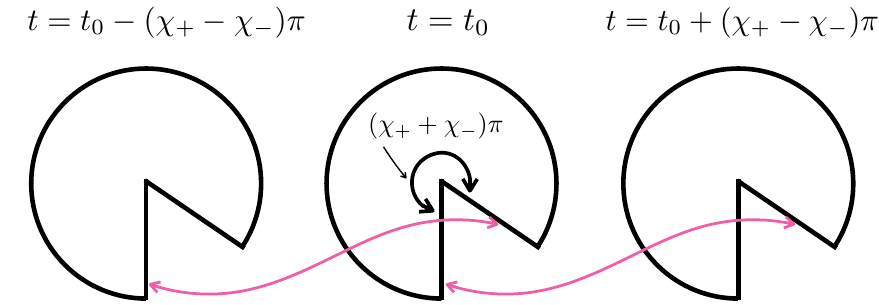
Figure 10 . The twisted identification to create a spinning defect from global AdS 3 . For each time slice t = t , we exclude a portion with angle 2 π − ( χ + χ ) π , and then paste it with another two 0 + − time slices t = t ( χ ) π , t = t + ( χ ) π in the way shown in the figure. Two lines 0 − + − χ − 0 + − χ − connected by the pink arrows are identified with each